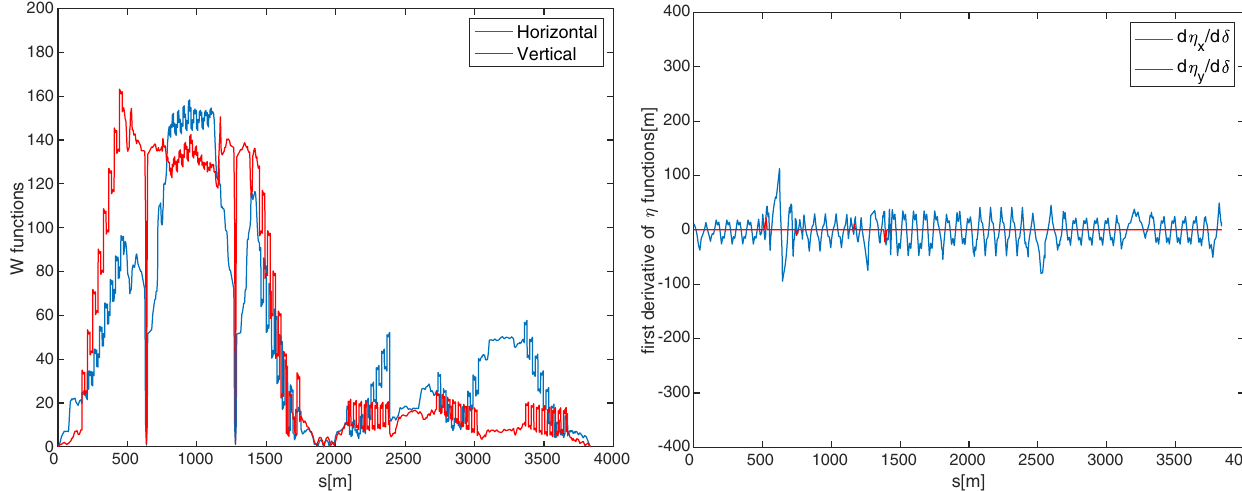
FIG. 10. The first-order chromatic optics in the electron storage ring with correction of the second-order dispersion.